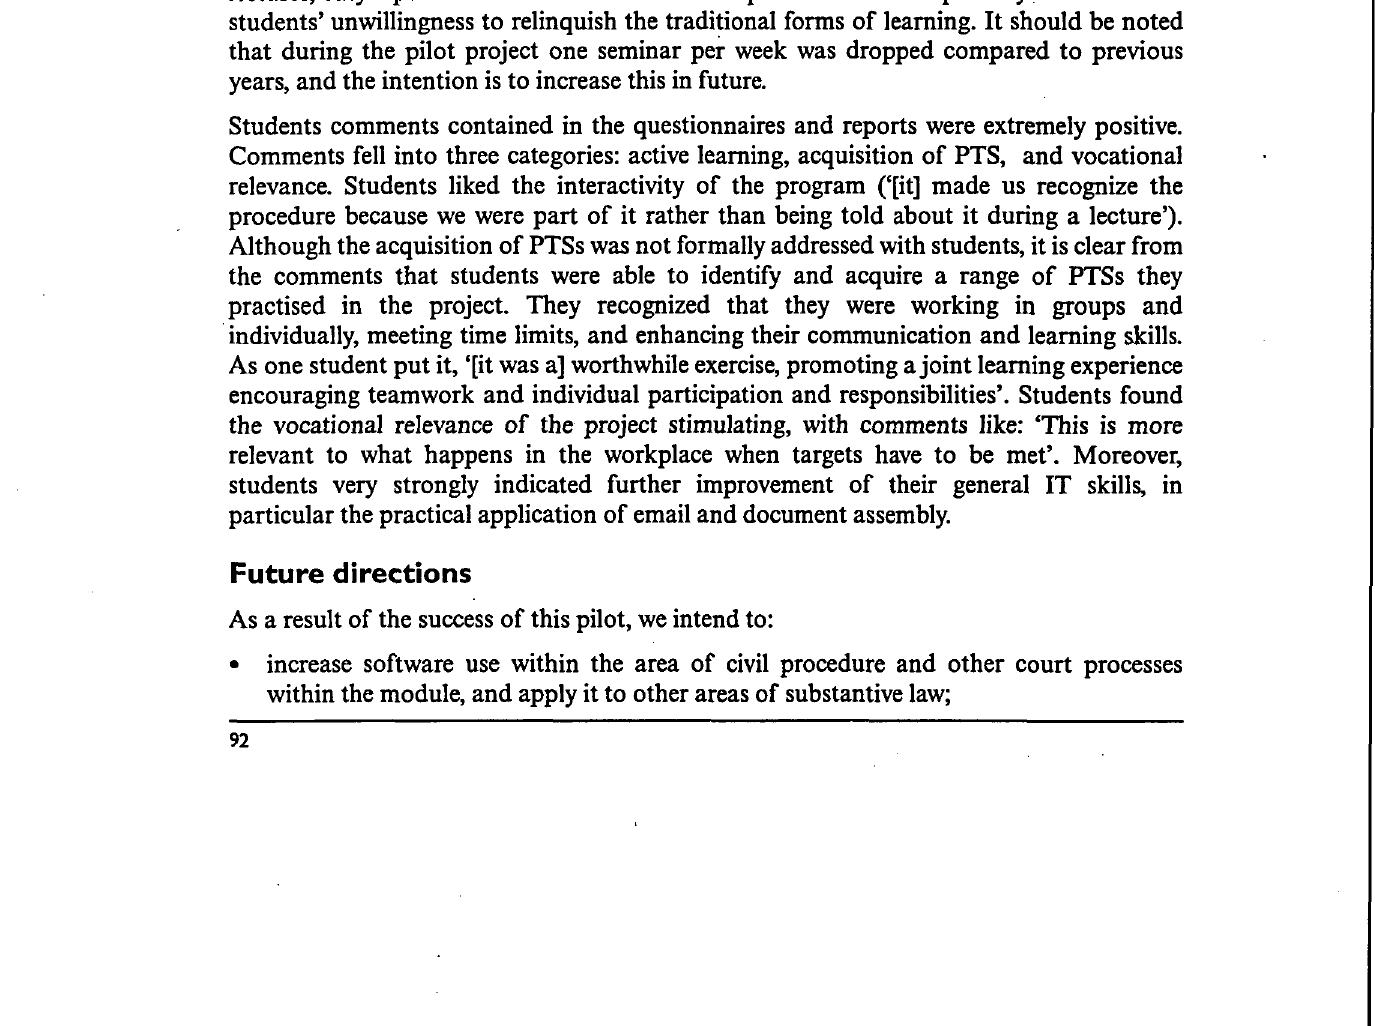
Figure I: Summary of student-feedback results would like to see the courseware extended within the module. An encouraging 94 per cent stated that their confidence level in procedure had increased. Similarly, 83 per cent indicated their confidence levels in document-drafting had increased. In neither case were students less confident. While confidence should not be equated with competence, it is axiomatic that confidence can be regarded as an indicator of how an individual expects to perform in a given